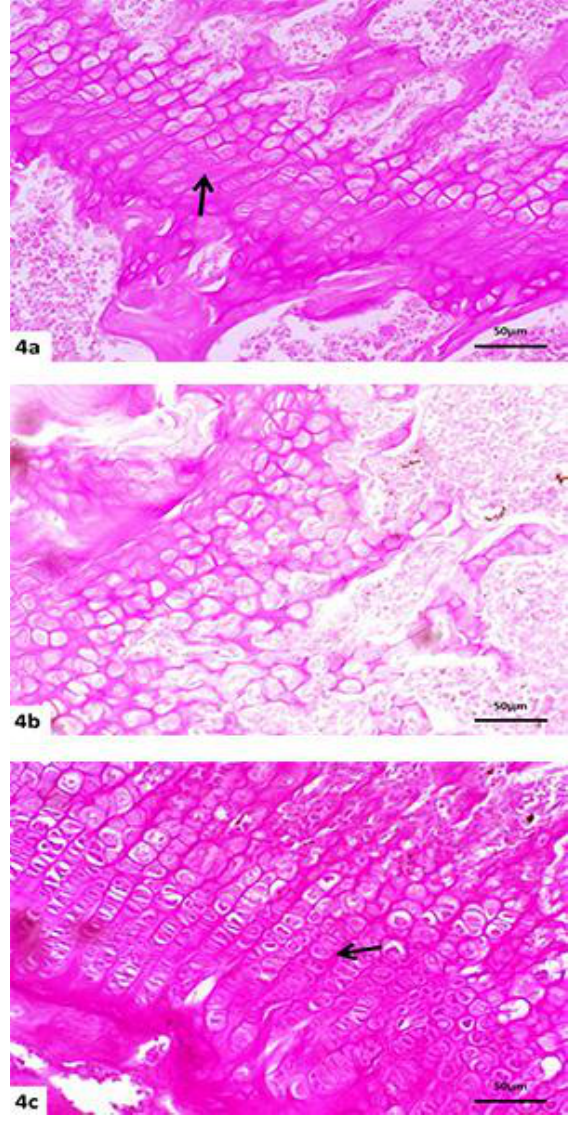
Figures (4a-c) : Photomicrographs of PAS stained sections in epiphyseal growth plate of tibia from (a): control group showing positive PAS reaction in the matrix (arrow). (b): PTU group showing diminished areas of PAS positive reaction in the matrix. (c): PTU+Ash group showing strong PAS positive reaction in the matrix (arrow). (4a-c x200- scale bar 50µm) Hippocampus (Dentate gyrus region) histological results Hematoxylin and eosin stained sections of control group revealed three layers; molecular (ML), granule cell (GL) and polymorphic layers (PL). The glial cells (astrocytes), blood capillaries and pyramidal cells were observed. Granule cells appeared with rounded vesicular nuclei. Small spindle shaped cells were seen in the sub-granular zone (Fig. 5a, b).